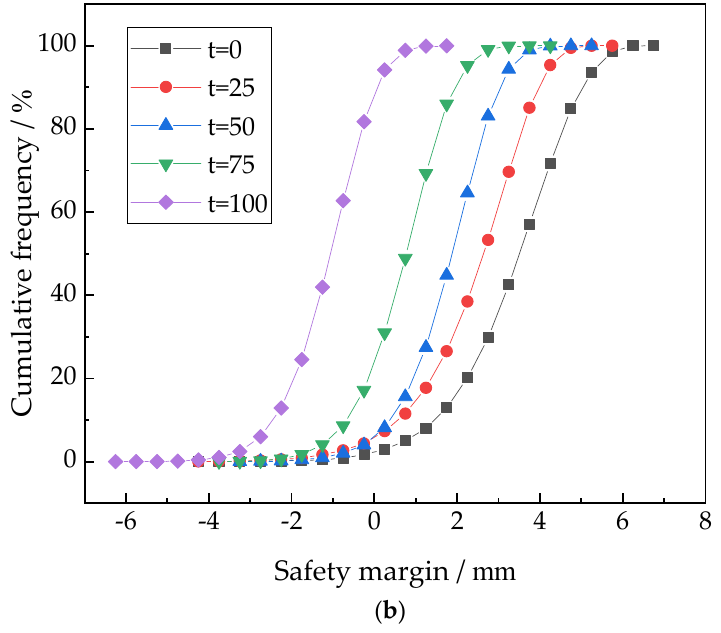
Figure 8. The influence of time-varying characteristics on the safety margin frequency distribution of horizontal displacement. ( a ) PDF curve. ( b ) CDF